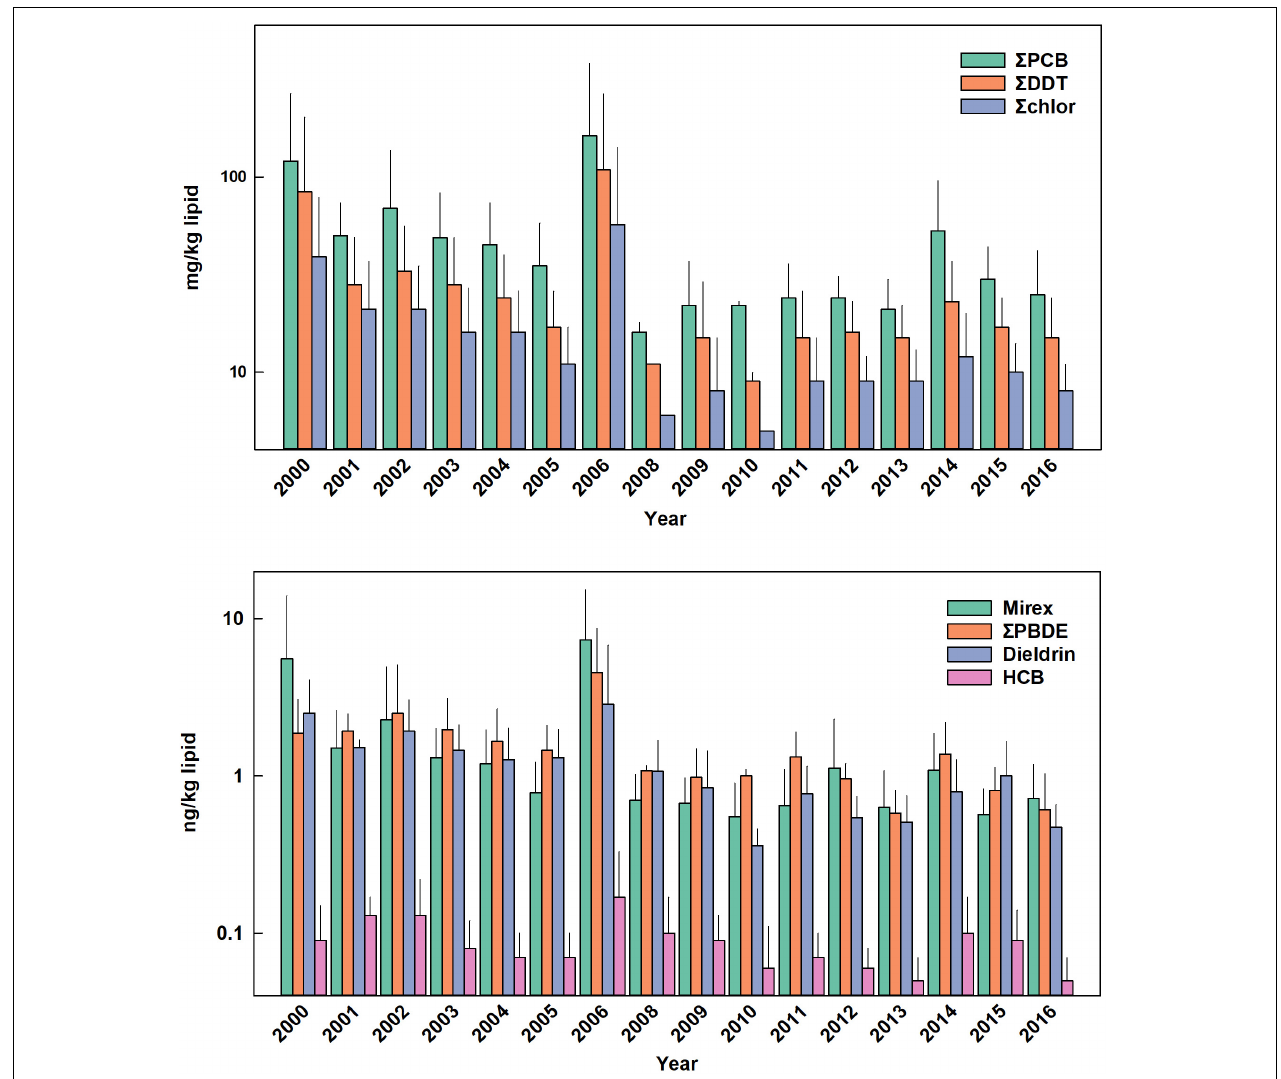
FIGURE 4 | Temporal trends of POPs in adult male and calf bottlenose dolphins. Bars are mean ± standard deviation. Values in parentheses are for error bars that are off scale.